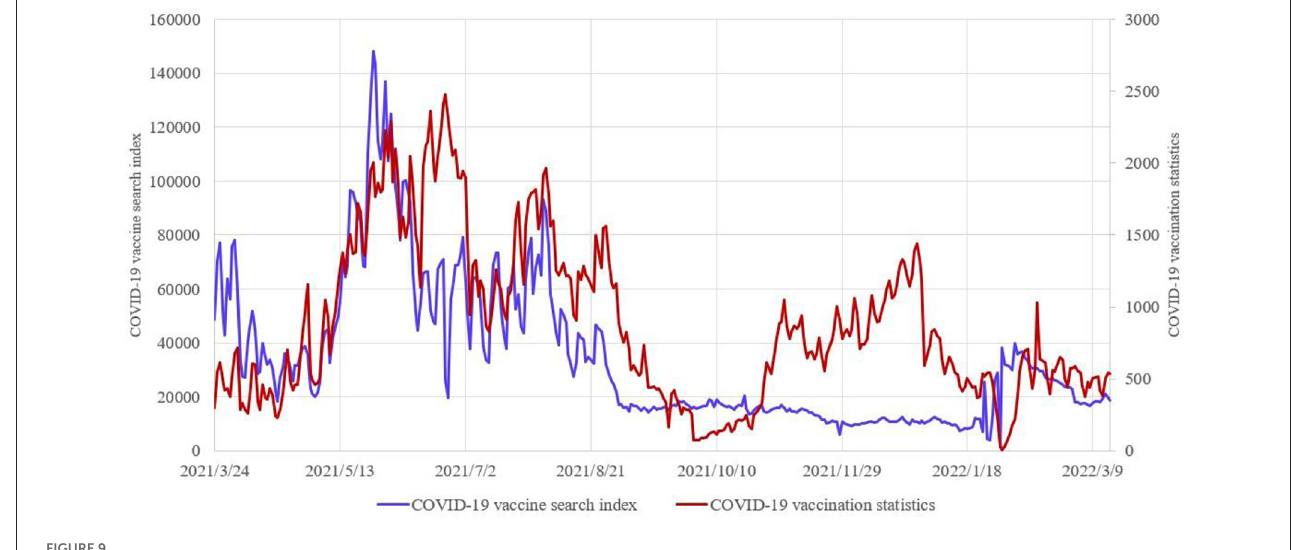
FIGURE9 Statistics of COVID-19 vaccination and Baidu search.